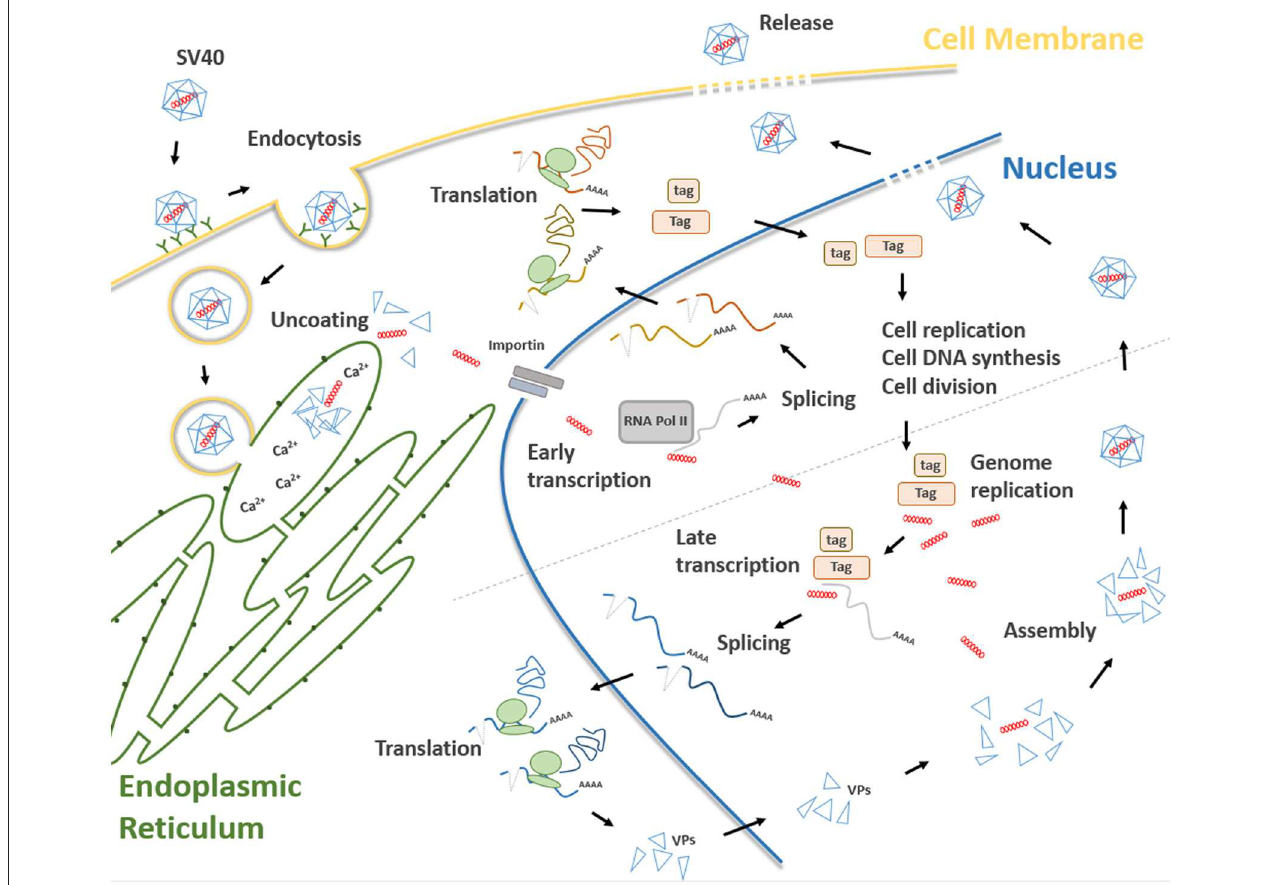
FIGURE 2 | Main steps of the SV40 life cycle. The life cycle of SV40 starts with the attachment of the SV40 viral capsid to the target cell surface and proceeds through a lipid raft-mediated endocytosis. Then, the virion is transferred, by vesicular transport, toward the endoplasmic reticulum where it starts the uncoating process which continues in the cell cytosol. Uncoated SV40 genomes translocate inside the nucleus where the cellular RNA polymerase II mediates early viral transcription. Early transcription generates a precursor that is alternatively spliced into mRNAs, encoding the large T (Tag), and small t (tag) antigens. These mRNAs are translated in the cytosol into their corresponding proteins. Tag and tag migrate to the nucleus where they mediate several functions interfering with a number of host cellular pathways, thereby forcing the cells to proceed from the G1 to the S-phase. At the same time, Tag/tag starts the replication of the SV40 genome. The transition from early to late phase during the SV40 infection begins at the end of the viral DNA replication. After synthesis, late viral proteins are accumulated in the cytoplasm, migrates into the nucleus and then assemble with replicated viral DNA to form virions. Finally, a progeny virus is released through cell